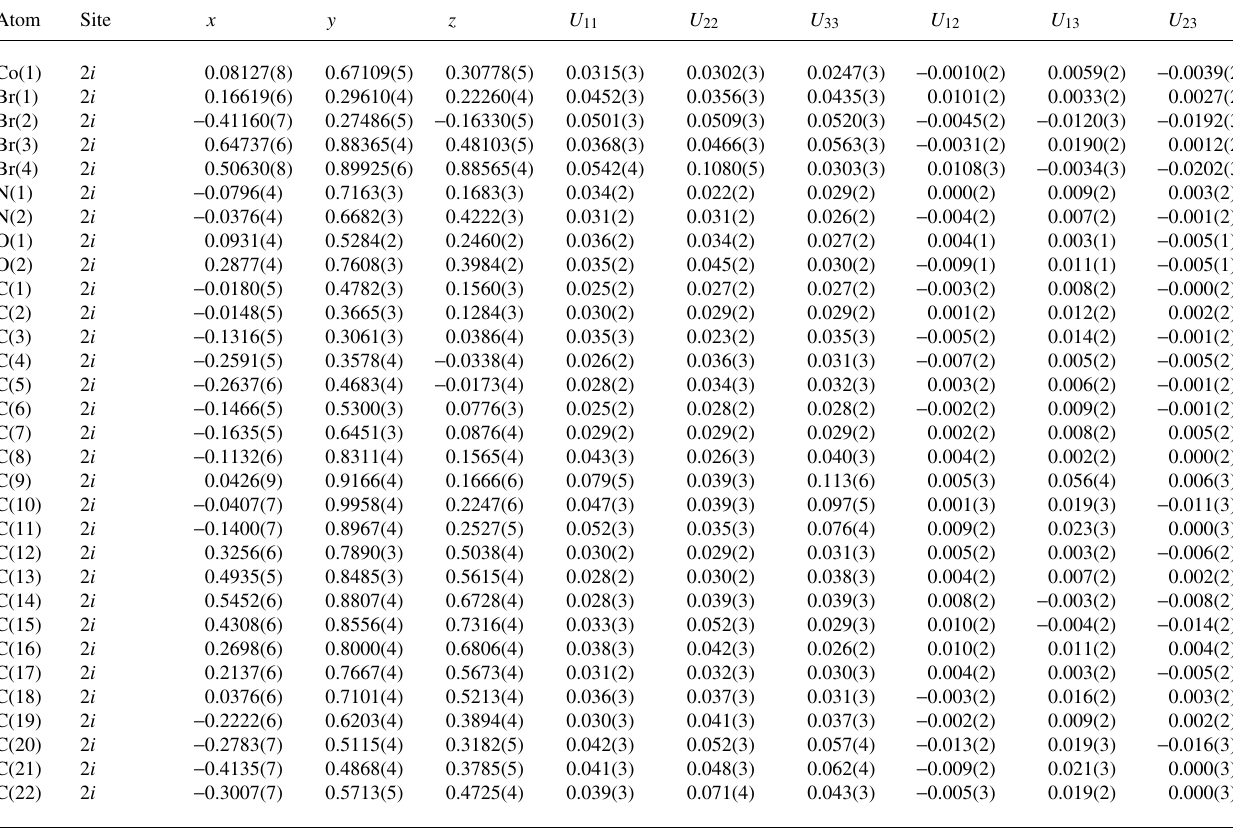
Table 3. Atomic coordinates and displacement parameters (in Å 2 )